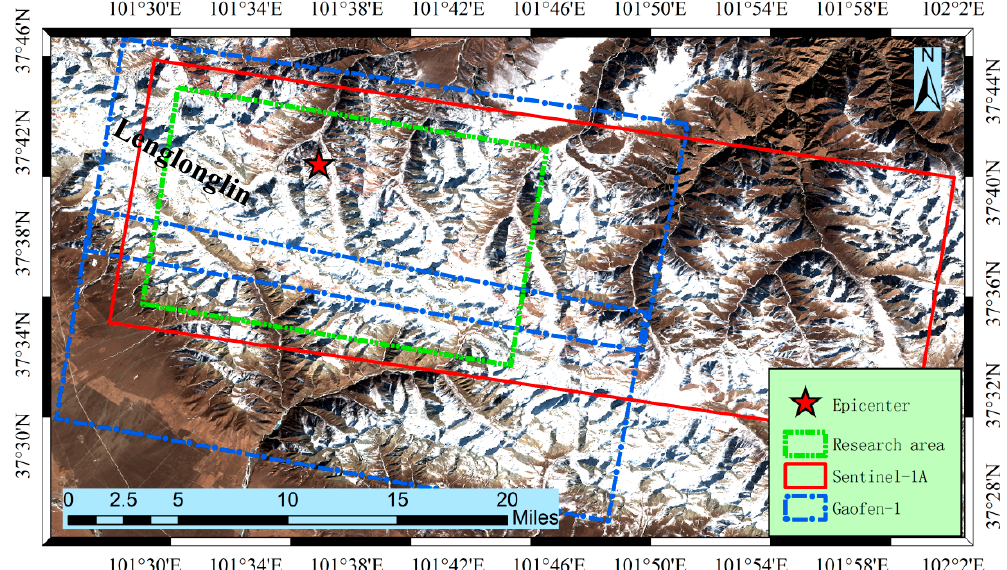
Figure 2. Sentinel-2A image acquired on 8 February 2016 showing the Menyuan earthquake area. The red star illustrates the proximate seismic center; the blue dashed rectangles show the footprint of Gaofen-1 optical images; the red rectangle is the Sentinel-1A burst area.